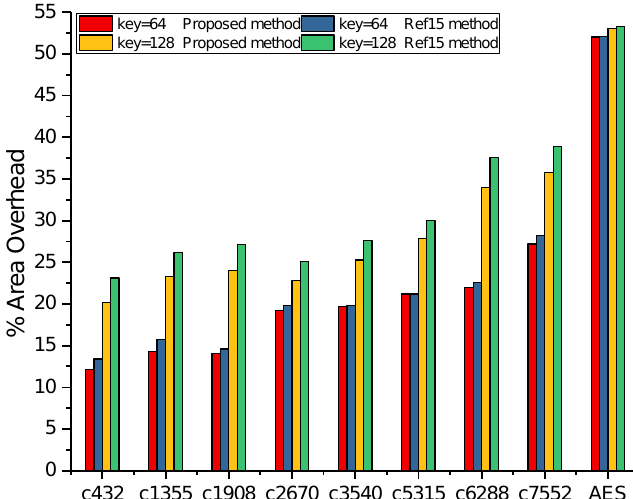
Figure 9. Area overhead for the proposed method and Reference [15] method.